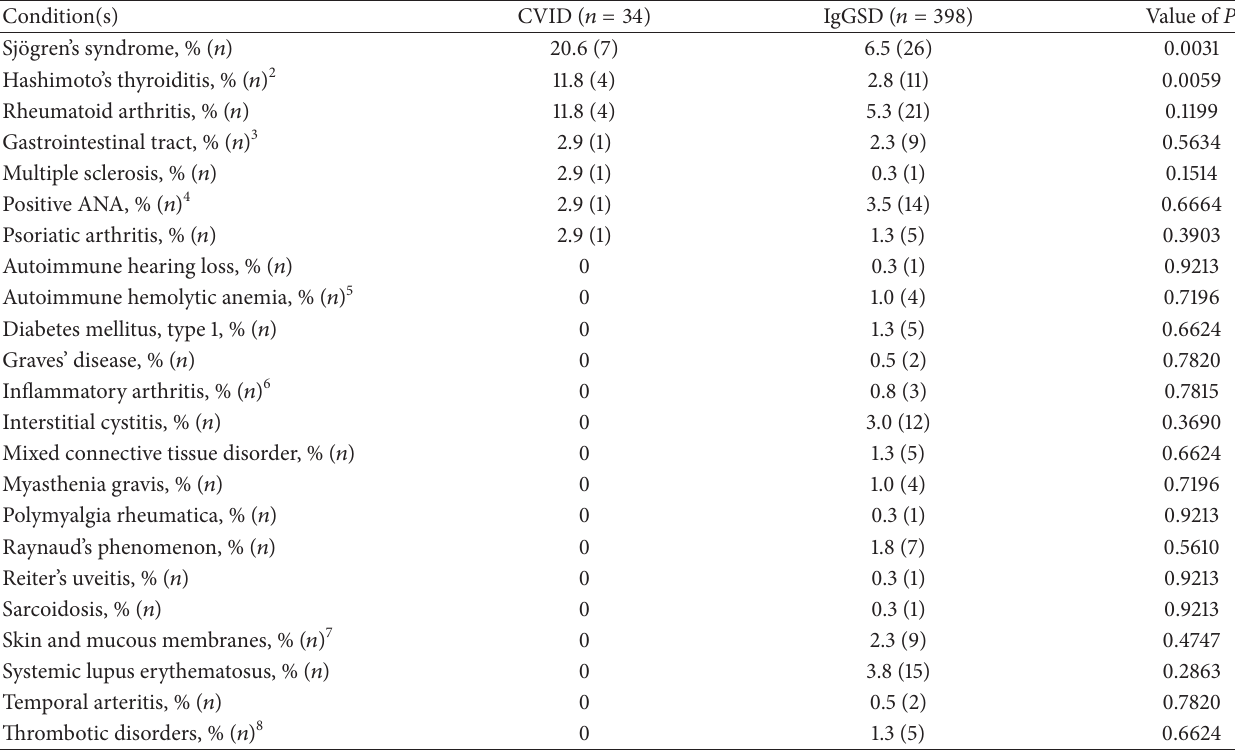
Table 2: Autoimmune conditions in 432 adult CVID/IgGSD index patients 1